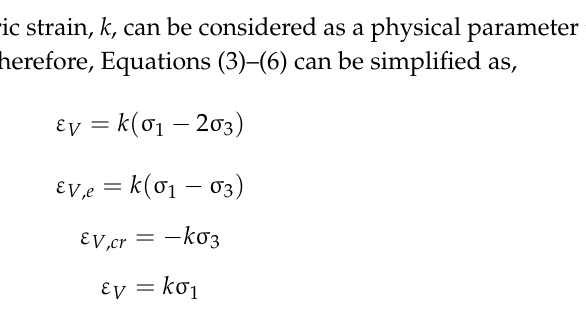
volumetric ε V , e strain, and the crack volumetric strain ε V , cr of shale are positively correlated with the coefficient of volumetric strain, k . Take the volumetric strain ε V for example. Samples usually have the largest Poisson’s ratio (close to 0.5) at inclination angle ( β ) of 45 ◦ , corresponding to the volumetric strain close to 0, which means that volume of the sample does not change. Volumetric strains are 0, either because pores and cracks do not open or close, or if opening is exactly compensated by